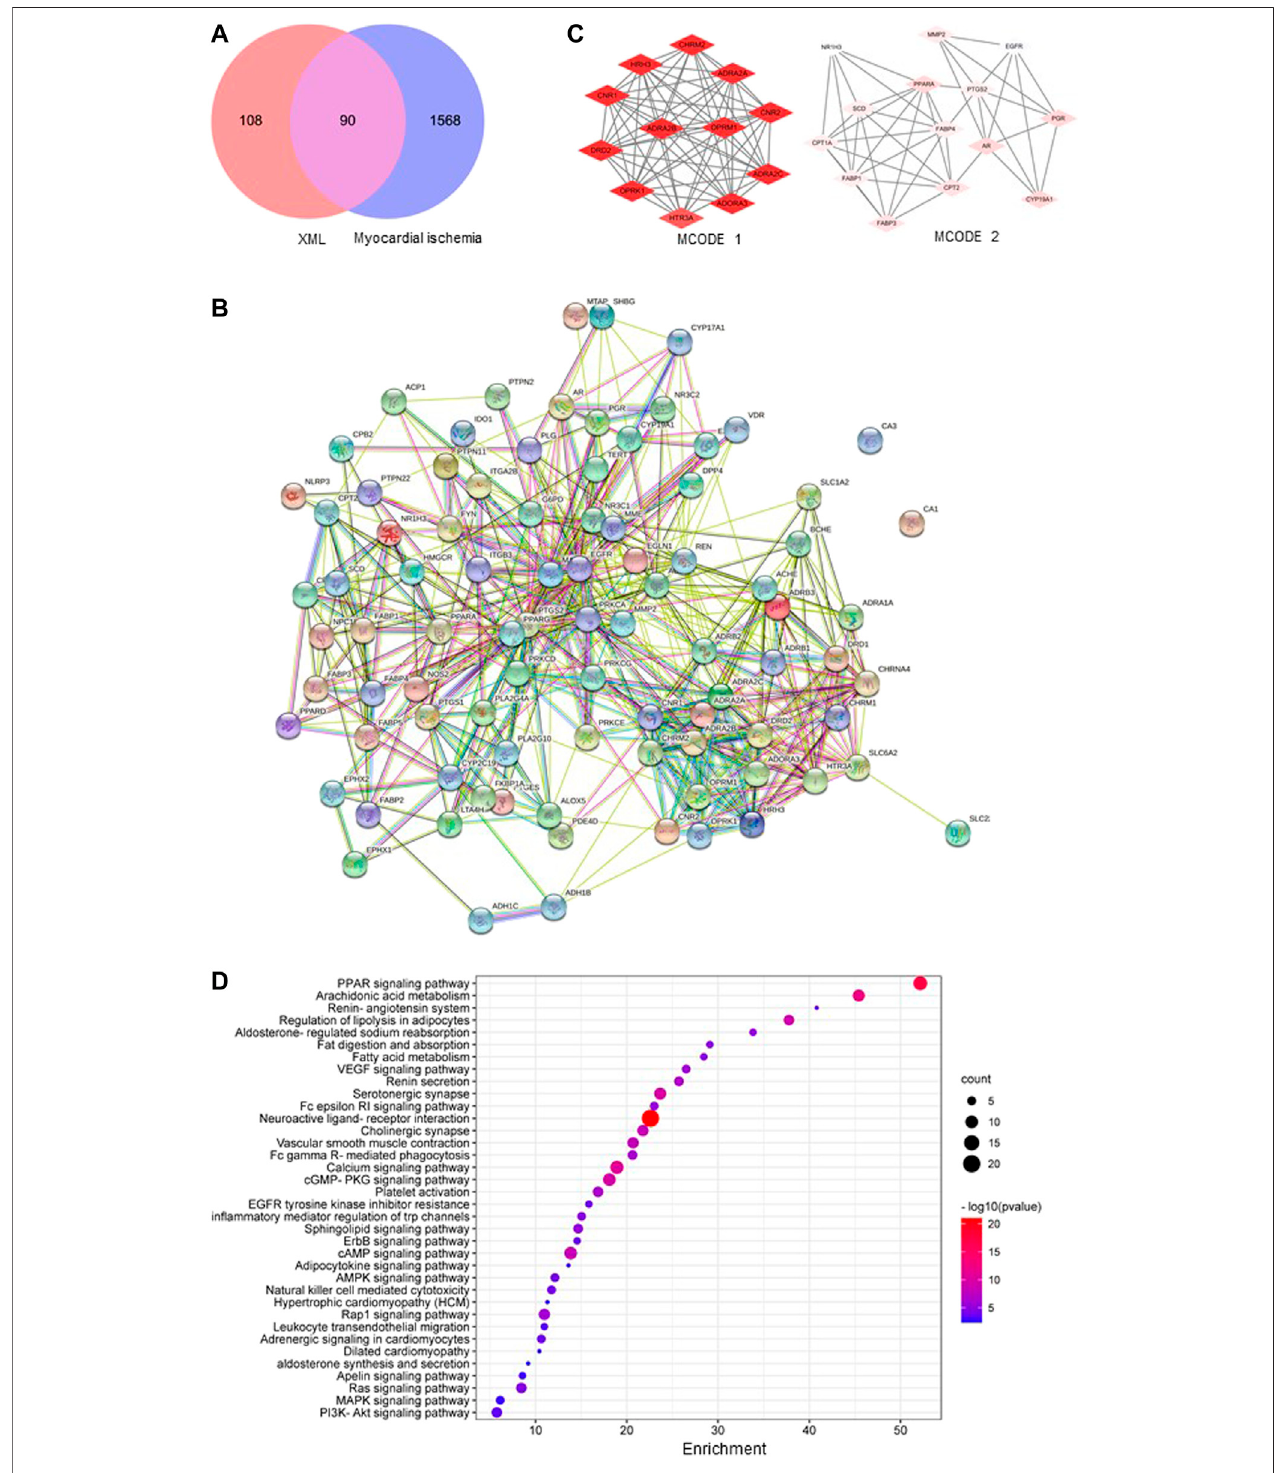
FIGURE3| Overlap ofgenesassociatedwithXMLtreatmentandmyocardialischemiaand their functions. (A) Anintersection generatedbetweengenesrelated to XML-activetargetsand myocardialischemia. (B) Protein – protein interaction networkoftheoverlappedgenesforXML andmyocardialischemia. (C) Thetop 2MCODEs from the PPI network. (D) Most enriched KEGG pathways for XML and myocardial ischemia overlapped genes.